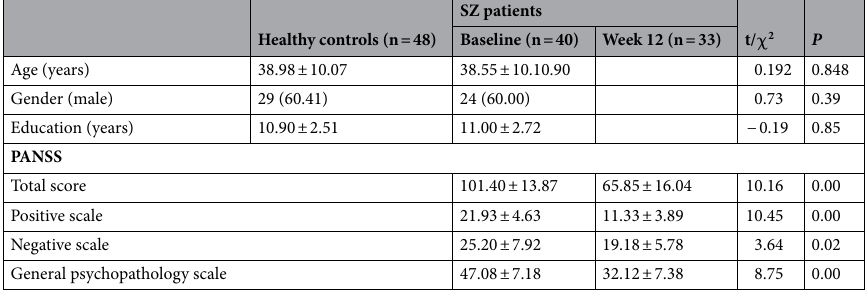
Table 1. Socio-demographic data of patients with schizophrenia and healthy controls. SZ schizophrenia, PANSS Positive and Negative Syndrome Scale.